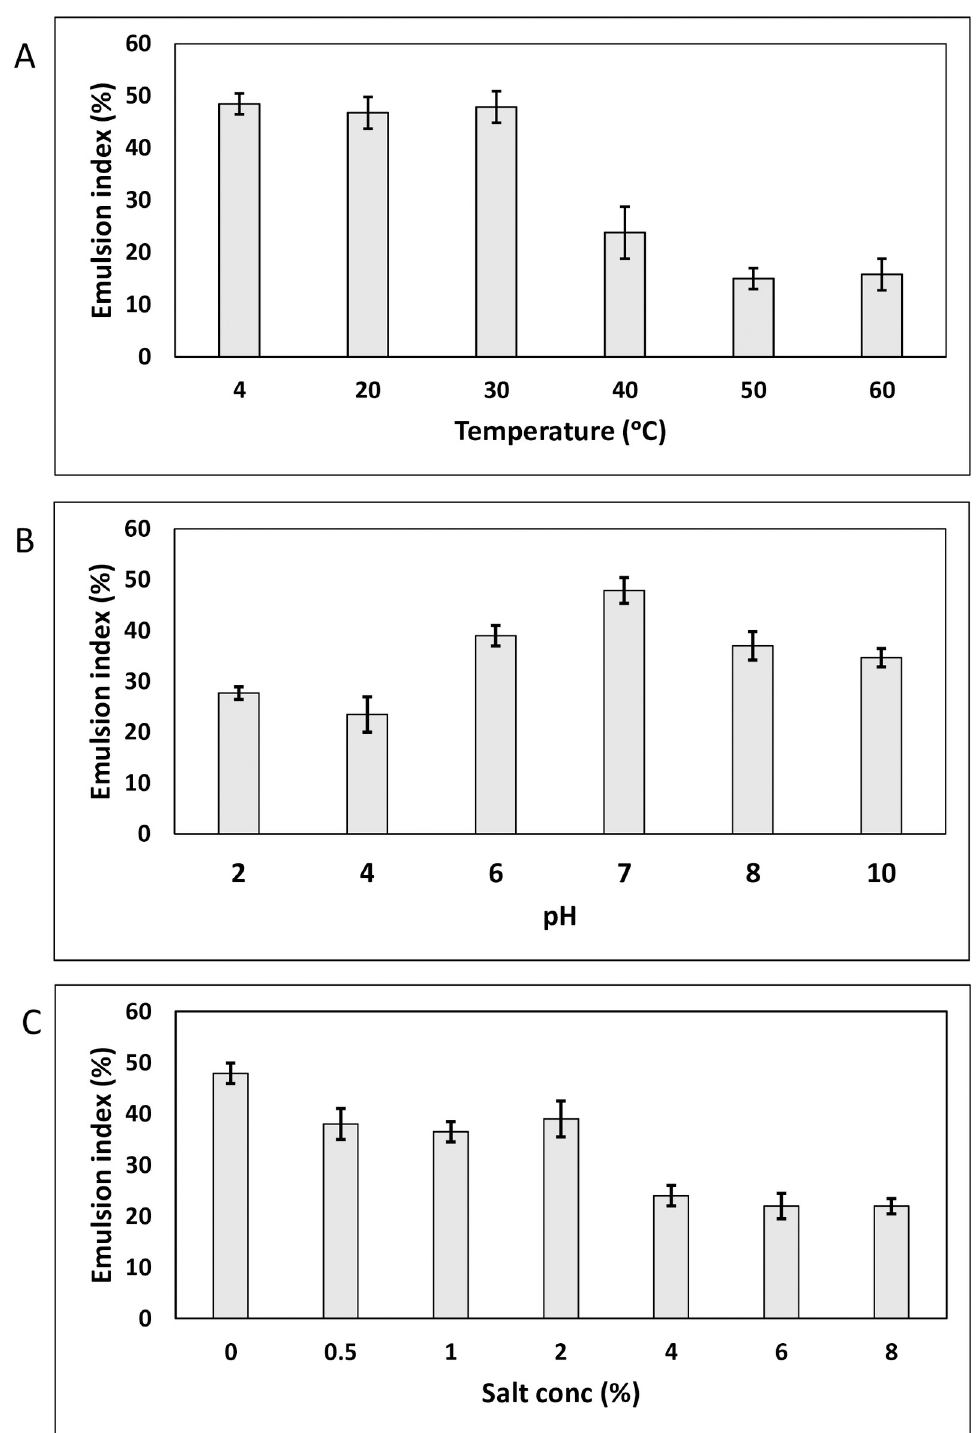
Fig 2. Emulsion stability studies: Effect of temperature (A), pH (B) and salt concentration (C) on emulsion stability. Statistical analysis of the results was performed using single factor ANOVA and p-values for temperature, pH and salt concentration profiles <